Question: According to this chart, does the measure grow or shrink?
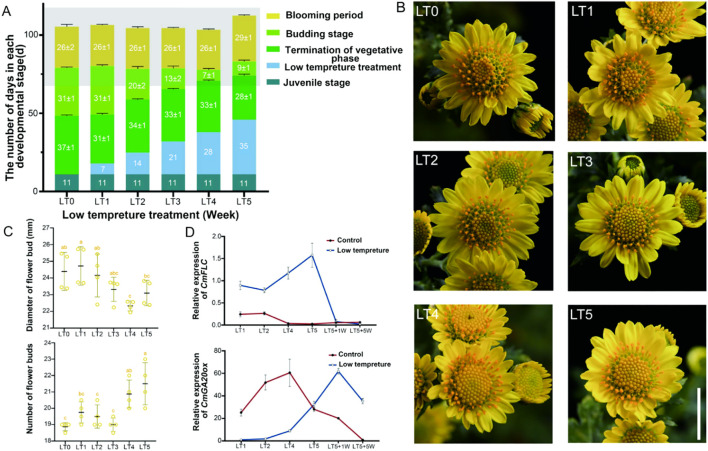
Answer: increasing